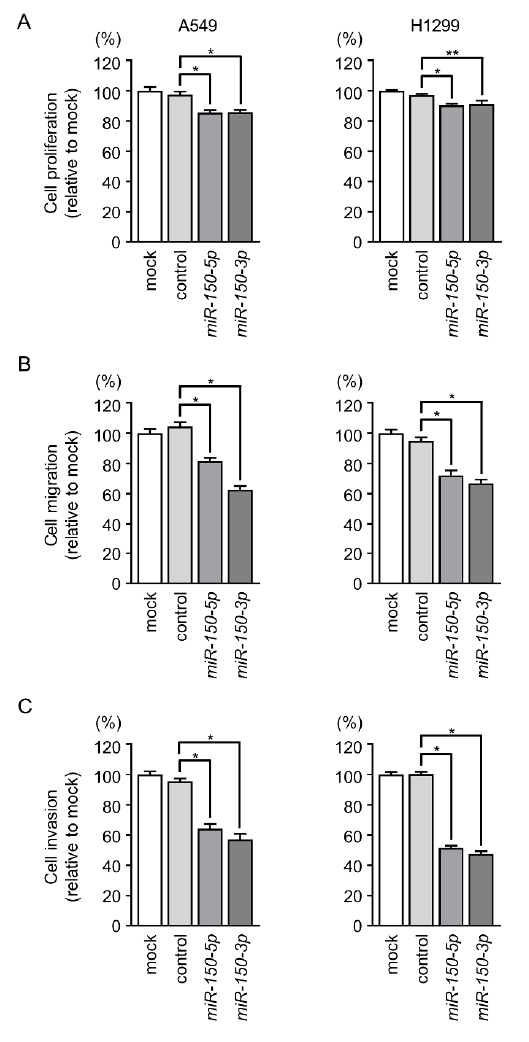
Figure 2. Functional assays of miR-150-5p and miR-150-3p in LUAD cells (A549 and H1299). ( A – C ) Cell proliferation, migration, and invasive activities were significantly blocked by ectopic expression of miR-150-5p or miR-150-3p . * p < 0.01, ** p <